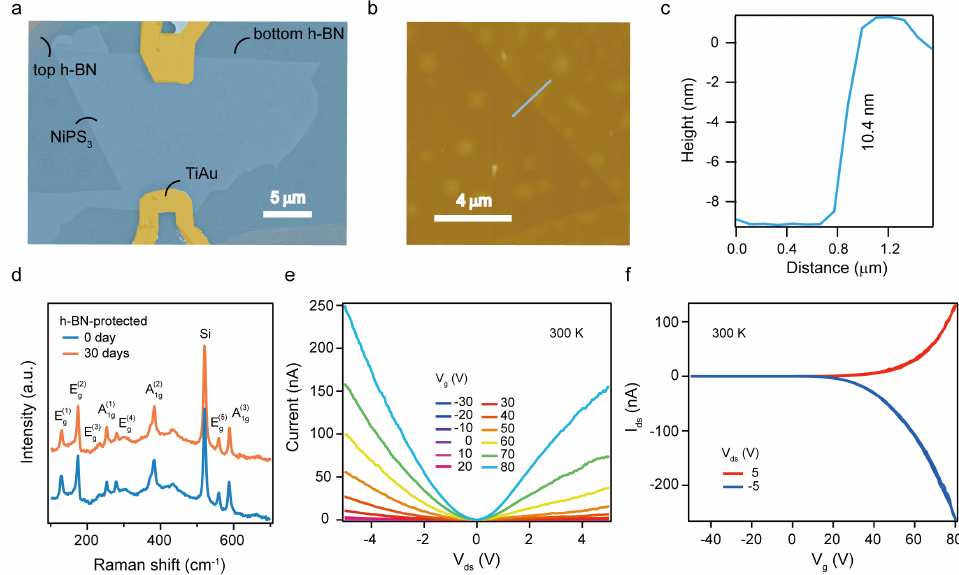
Figure 2. Electrical properties of the few-layered NiPS 3 field effect transistor. ( a ) False-colored scanning electron micrograph (SEM) image of the few-layered NiPS 3 device. ( b ) AFM image of vdWs heterojunction in ( a ). ( c ) The corresponding height profile of the heterojunction along the blue line in ( b ). ( d ) Raman spectra of the hBN-encapsulated NiPS 3 obtained after 0 day (blue solid line) and 30 days (orange). ( e ) The current-voltage characteristics at different gate voltages (V g ) as given in the figure for the NiPS 3 FET device at 300 K. V ds is the source-drain voltage. ( f ) The transfer curves at 5 V and − 5 V source-drain voltage for the same sample in ( e ) at 300 K. I ds is the source-drain